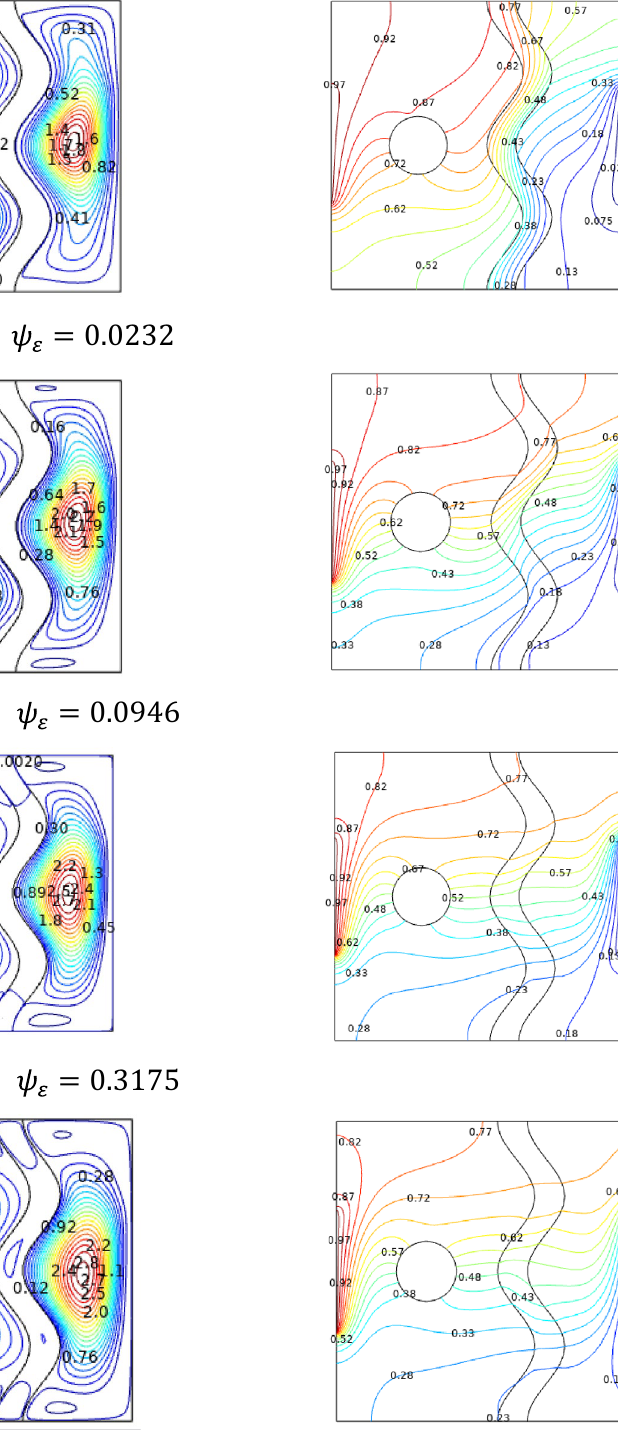
Figure 5. Variations of the streamlines (left), isotherms (right) with various Darcy number ( Da ) at, Ra 0 , N 0.2 and ω 0 0.02 , ε 2 , φ Ha = = = = =